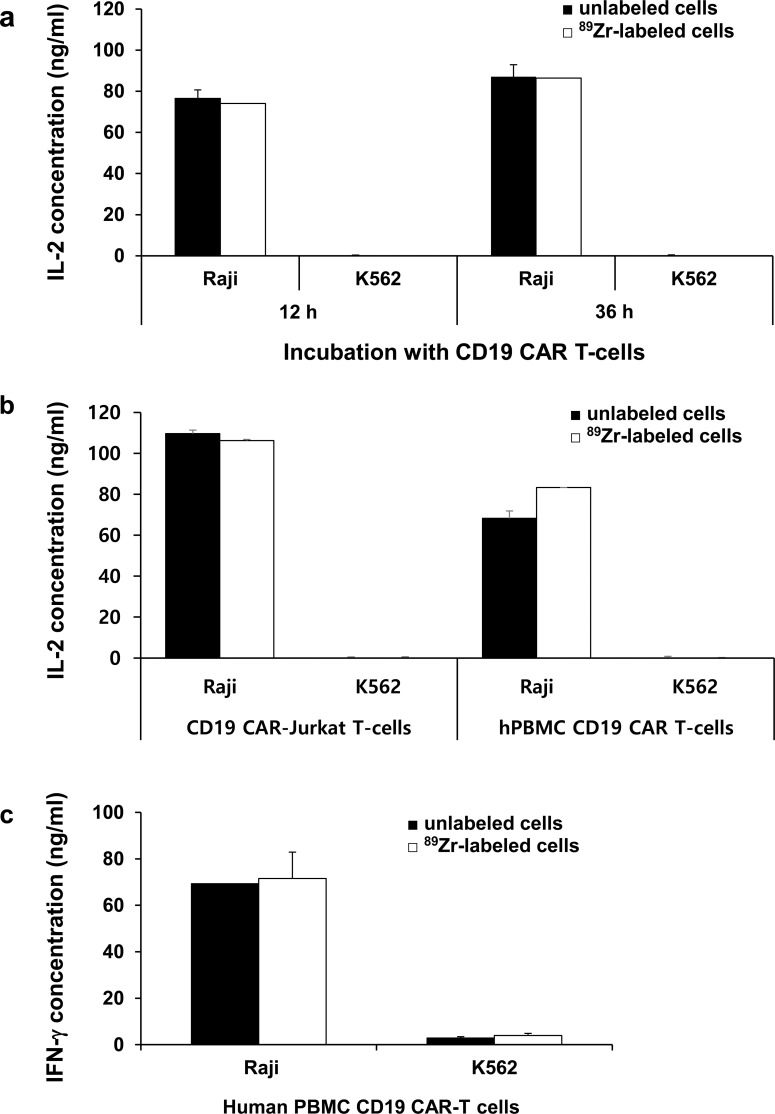
Cell function test after 89Zr-DFO-labeled Jurkat/CAR T-cells and hPBMC CAR T-cells.a Function test by IL-2 production of 89Zr-DFO-labeled Jurkat/CAR T-cells after incubation with Raji (CD19 positive) or K562 (CD19 negative) cells. Incubation time was 12 hours or 36 hours, and unlabeled cells were used in the experiment as a control group. b Function test by IL-2 production of 89Zr-DFO-labeled Jurkat/CAR T-cells or hPBMC CAR T-cells after incubation with Raji or K562 cells. c IFN-γ test of 89Zr-DFO-labeled hPBMC CAR T-cells with Raji or K562 cells. Data are representative of at least two independent experiments. All data are expressed as means and standard deviations.